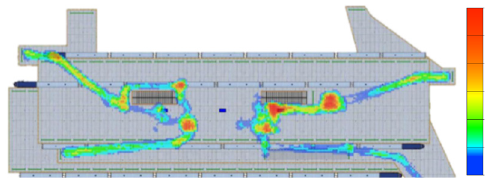
Figure 15. Scenario of 70% female evacuation.